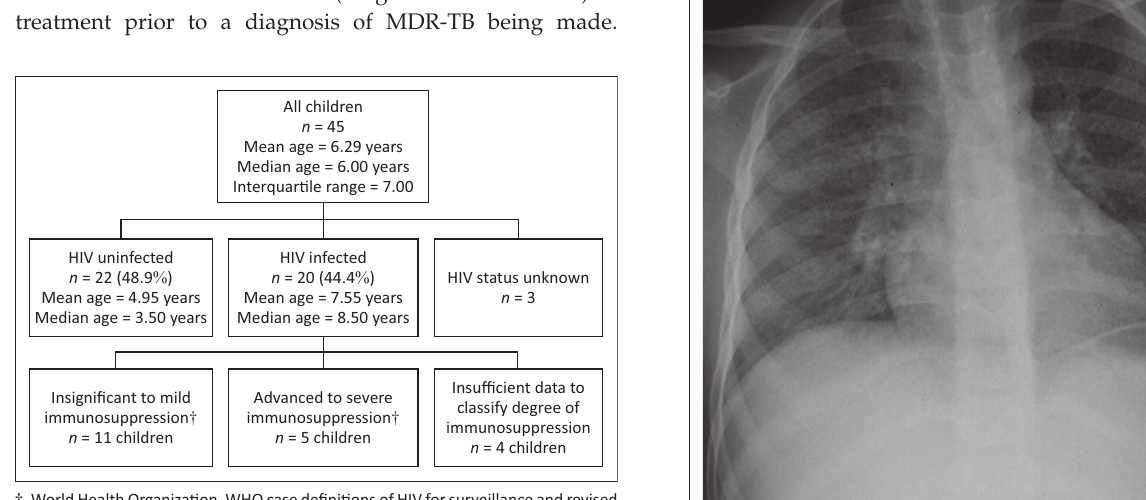
FIGURE 1: Demographics.